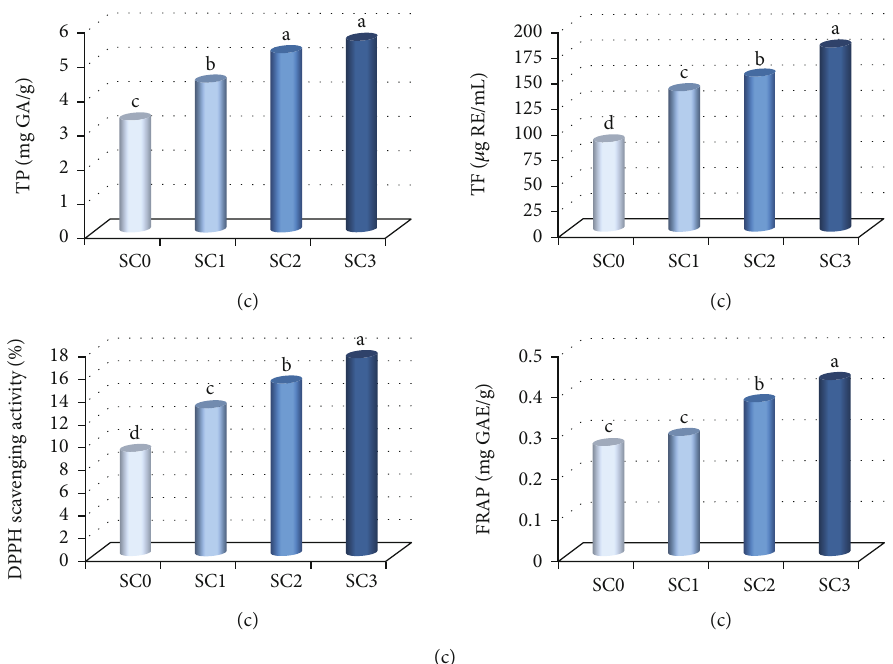
Figure 2: Bioactive compounds and antioxidant activity of (a) wa ffl es, (b) breadsticks, and (c) salad cream. TP: total phenolic; TF: total fl avonoid; RE: rutin equivalent; GAE: gallic acid equivalent; FRAP: ferric reducing antioxidant power; DPPH: 1,1-diphenyl-2-picrylhydrazyl. Table 7: Color measurement of wa ffl es, breadsticks, and salad cream. Products